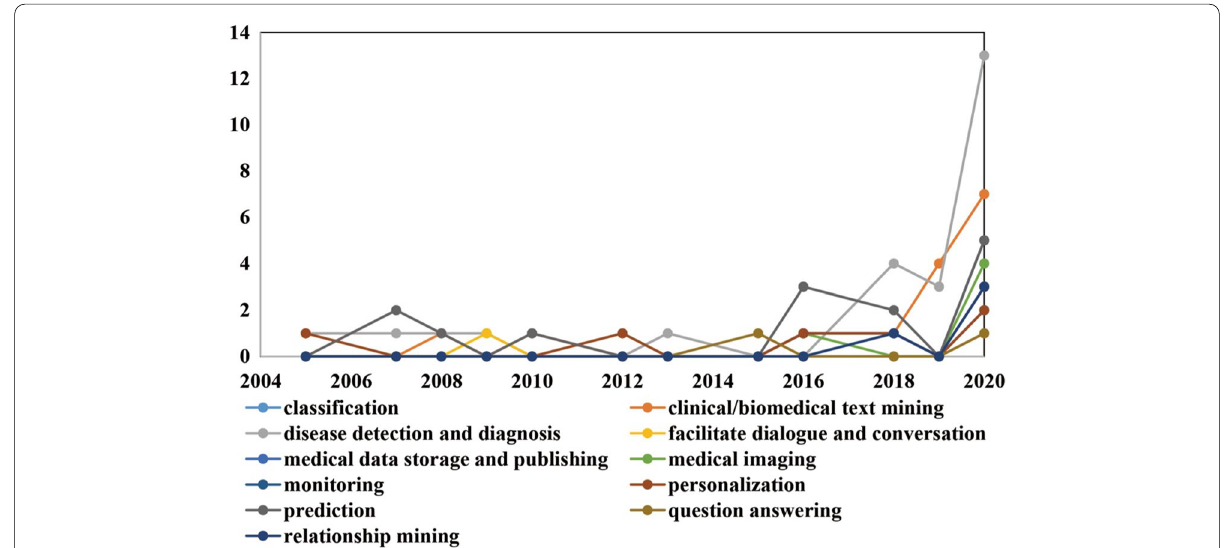
Fig. 11 Distribution of clinical tasks by